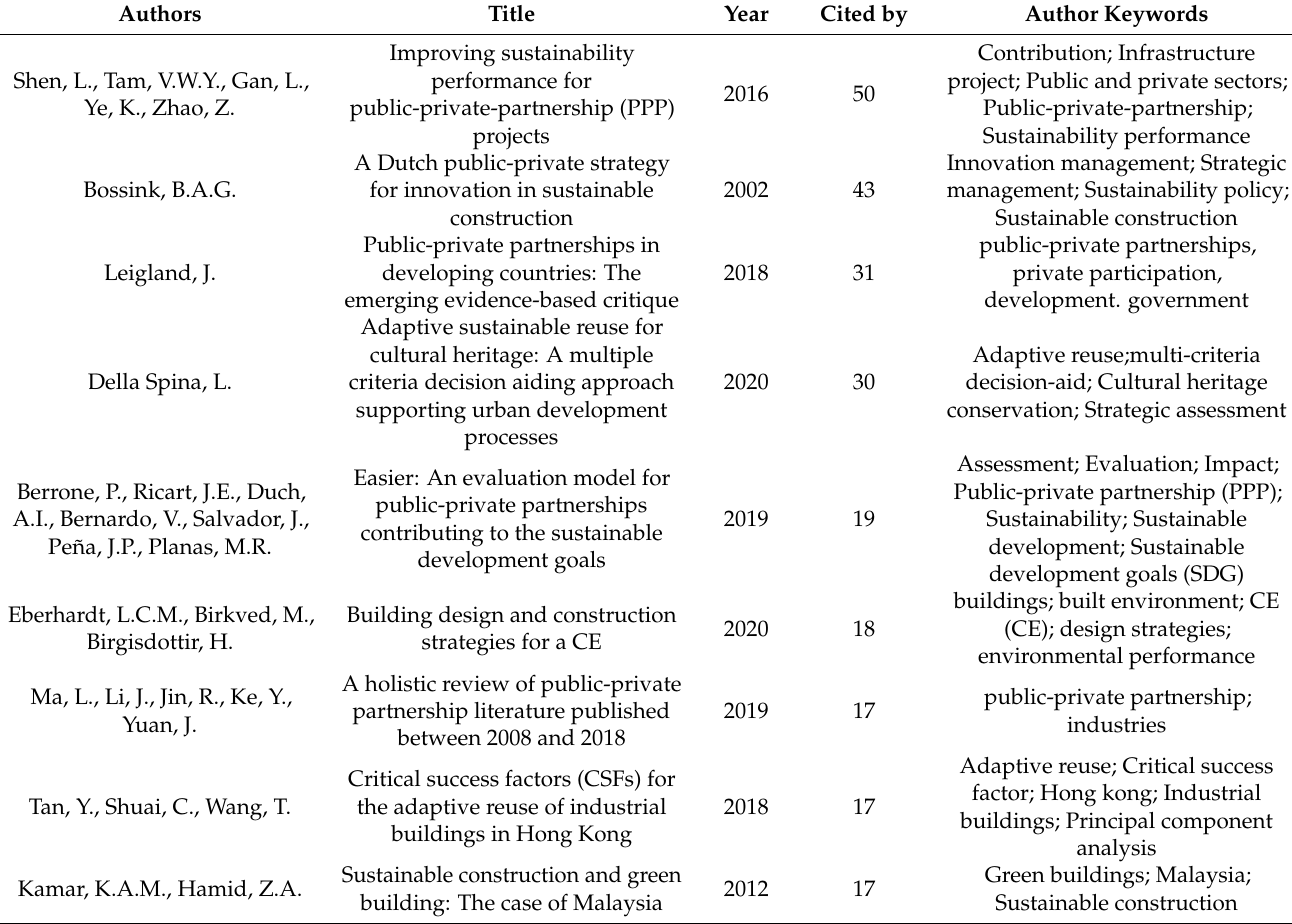
Figure 4. Output distribution by source. Table 1. Most productive authors in PPP-related studies on CE in the built